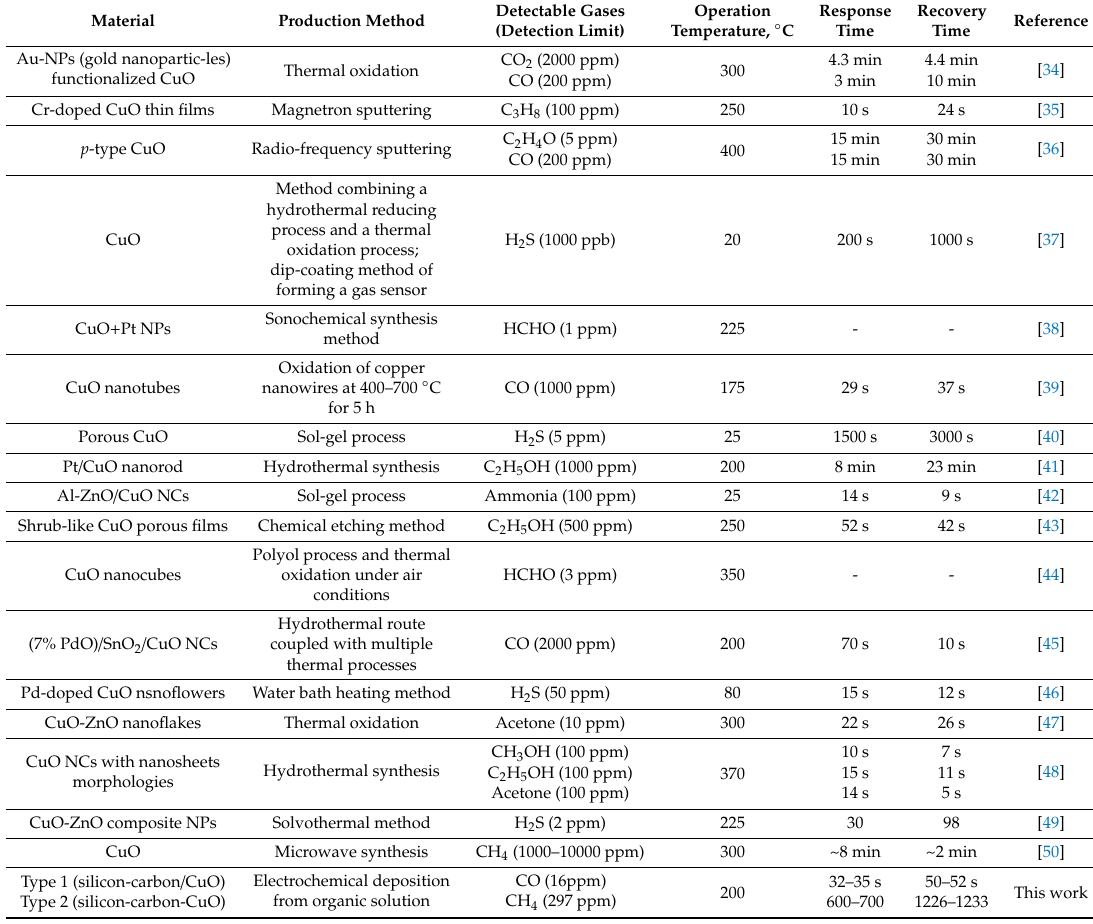
Table 1. Comparison of reported CuO-based gas sensors fabricated by di ff erent